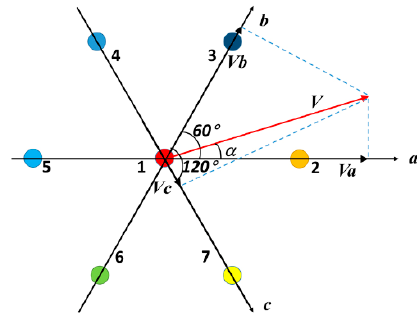
Figure 3. Schematic illustration of the principle of velocity measurement. Different color circles denote MCF cores; V a is the velocity component of V on the a-axis; V b is the velocity component of V on the b-axis; and V c is the velocity component of V on the c-axis.